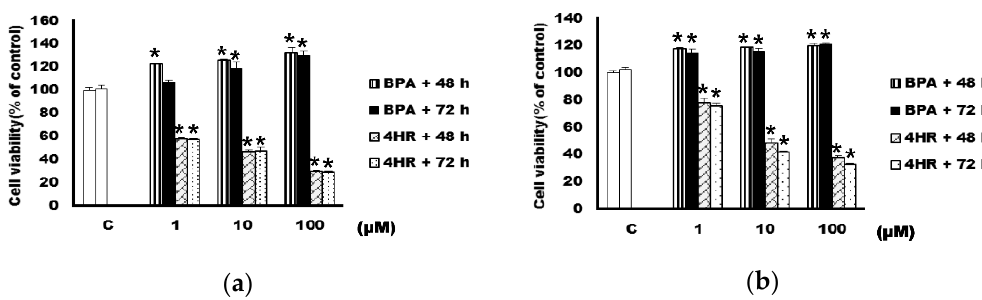
Figure 1. The results of MTT assay. ( a ) The application of BPA (1 to 100 µ M) to MCF-7 cells showed increased value compared to solvent only group at 48 and 72 h after administration. However, the application of 4HR with the same range of concentration showed decreased value compared to the solvent only group at both 48 and 72 h after administration. ( b ) The same trends were observed in SK-BR-3 cells (* p < 0.05).